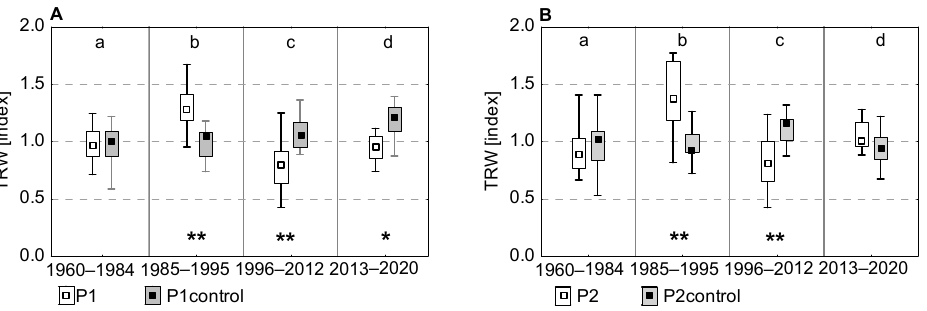
Figure 6. Box plots showing differences in means TRW (median) between the study stands in the different tree growth periods: a–25 years before the start of FWTP activity; b–the first 11 years of the FWTP operation; c–next years of the FWTP operation; d–years after the FWTP was closed. ( A )–plots with younger trees; ( B )–plots with older trees. Asterisks indicate a significant difference amongst mean tree-rings widths of Scots pine on study plots; * represents that 0.01 < p -value < 0.05; ** represents that 0 < p -value < 0.01.